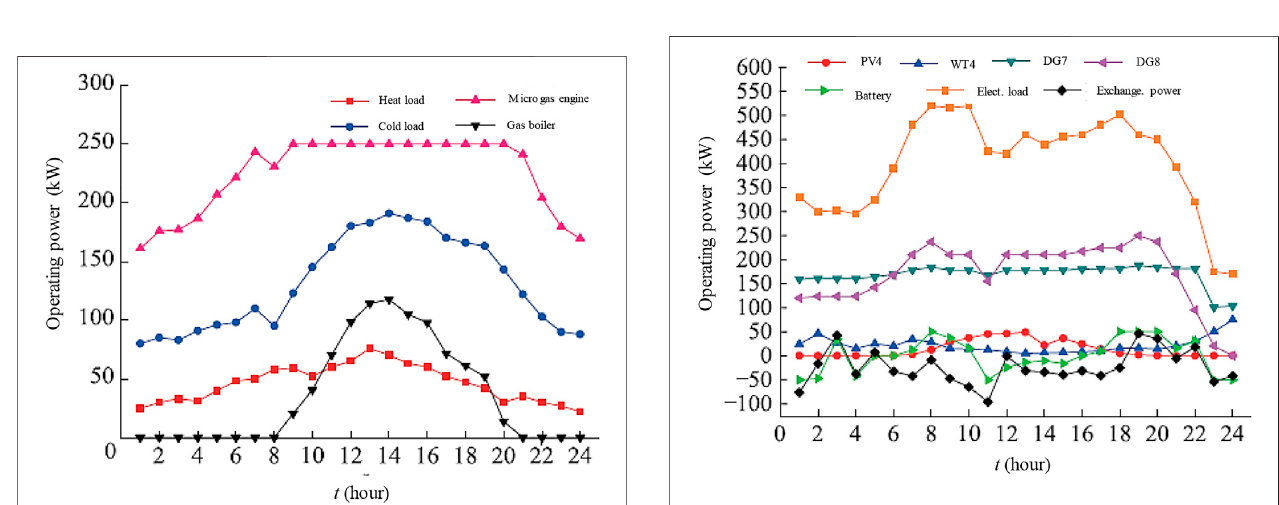
FIGURE 11 | Comparison of thermal optimization of the second region.